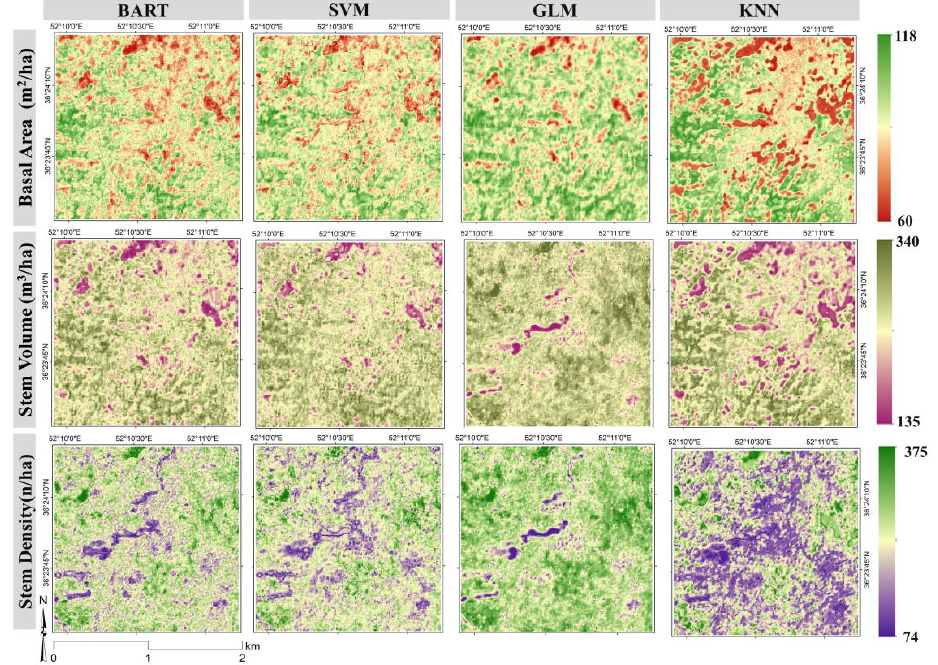
Figure 5. Mapping of the forest stand characteristics using BART, GLM, KNN and SVM in a 2 X 2 km 2 study area.